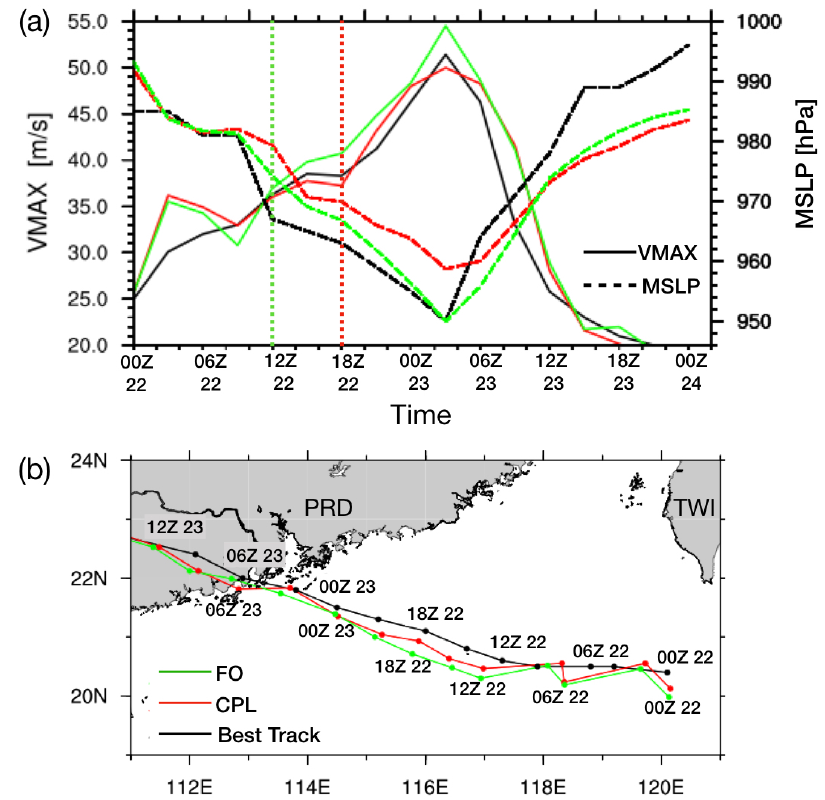
Figure 2. The comparison of typhoon trajectory and intensity between the best track data and the simulated results. ( a ) The 10-m maximum sustained wind speed (VMAX in solid lines, m s − 1 ) and MSLP (dash, hPa) from the best-track data set (black), control simulation (CPL, red), and the fixed ocean experiment (FO, green). The dotted lines denote the onset of RI in both storms. ( b ) The zoomed map of the northern SCS and the 3-hourly storm centers in the same color bar with ( a ). The dots with numbers indicate TC centers at the specific time in August. TWI denotes the Taiwan Island and PRD is for the Pearl River